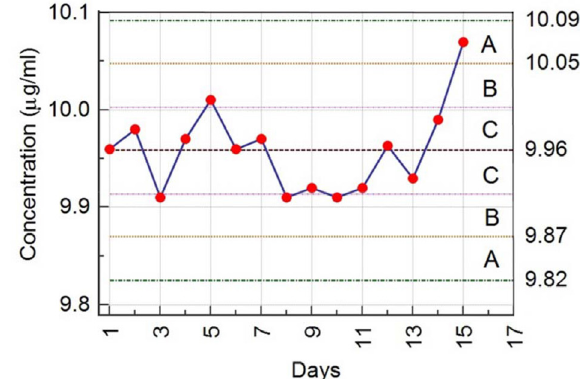
Fig. 5. Control chart showing the accuracy of the